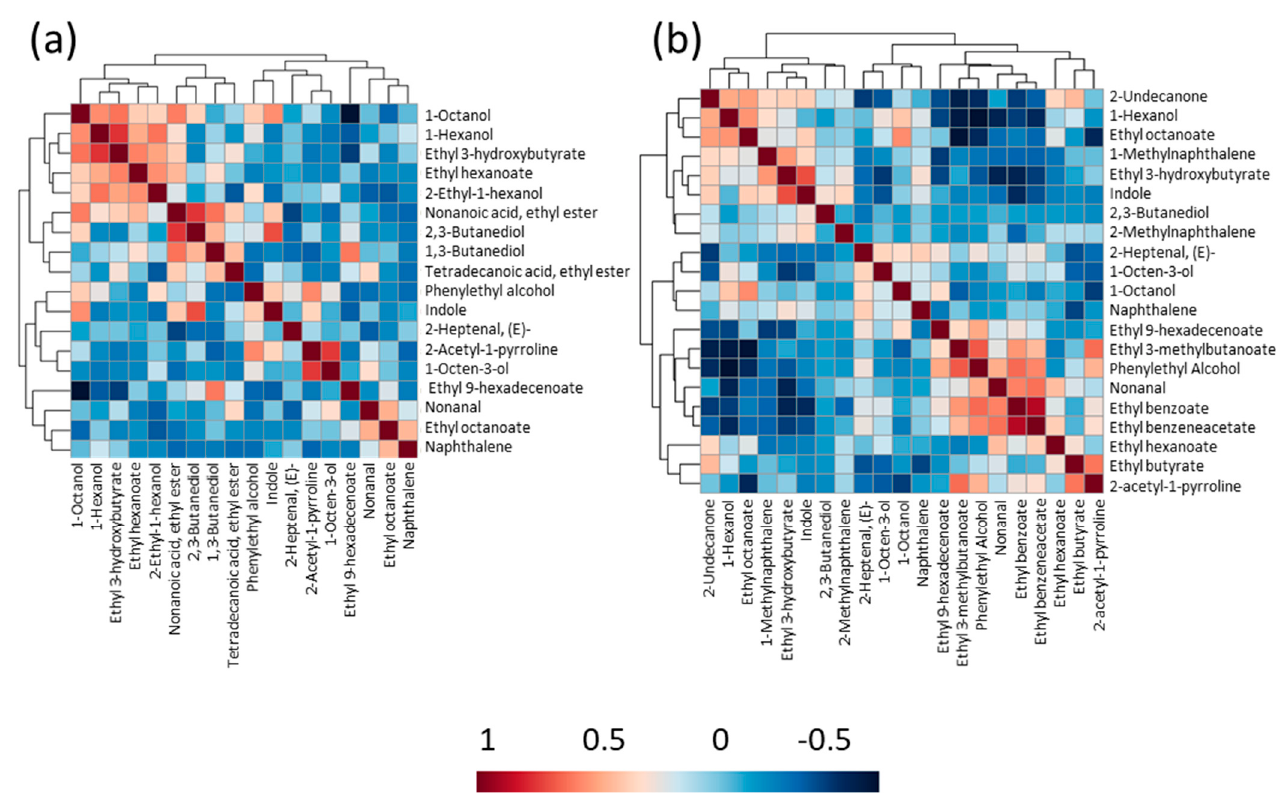
Figure 3. Heatmap of correlation matrix of the volatile compounds in ( a ) raw rice and ( b ) cooked rice of ten different traditional and improved varieties. Red-colored squares indicate positive correlations and blue-colored squares denote negative correlation.